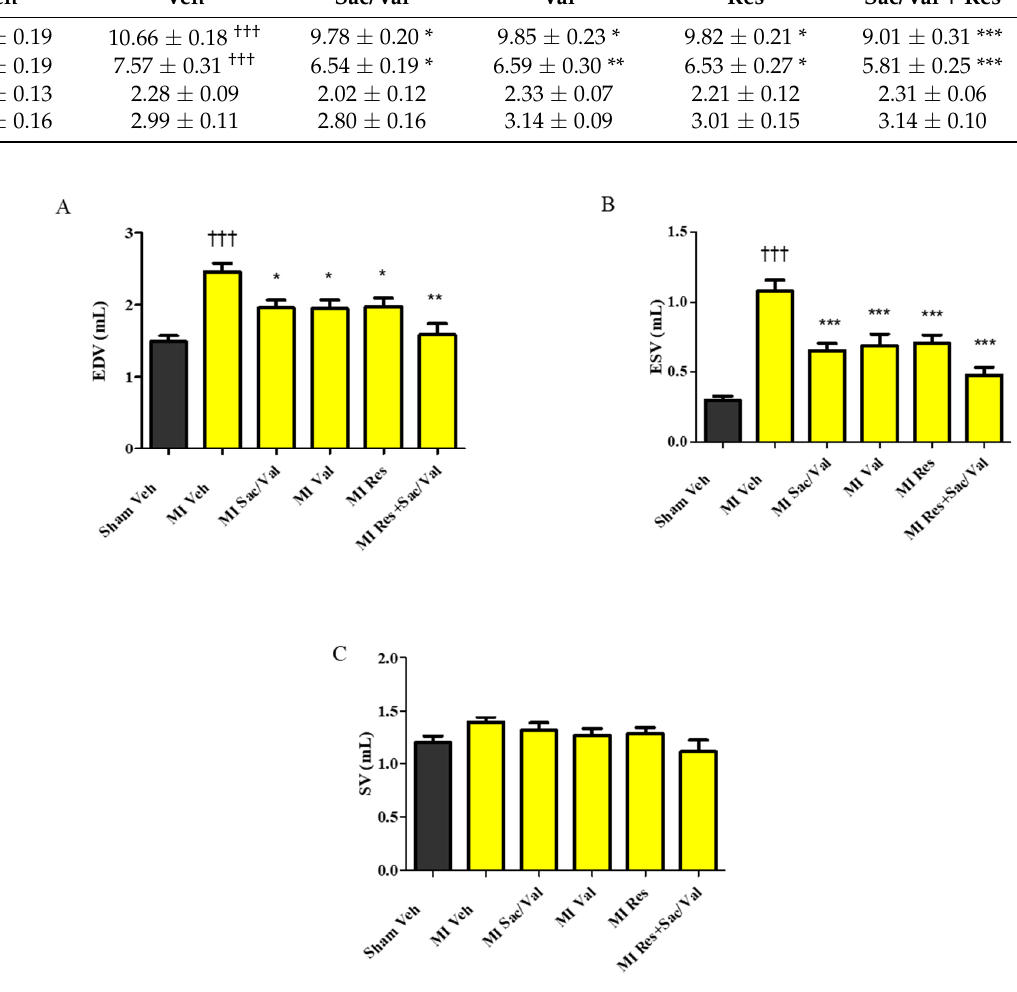
Figure 2. ( A ) End diastolic volume (EDV); ( B ) End systolic volume (ESV); ( C ) Systolic volume (SV). All values are ex- pressed as mean ± SEM, n =9–11. ††† p < 0.001 vs. Sham Veh; * p < 0.05, ** p < 0.01, *** p < 0.001 vs. MI Veh. Veh—vehicle,